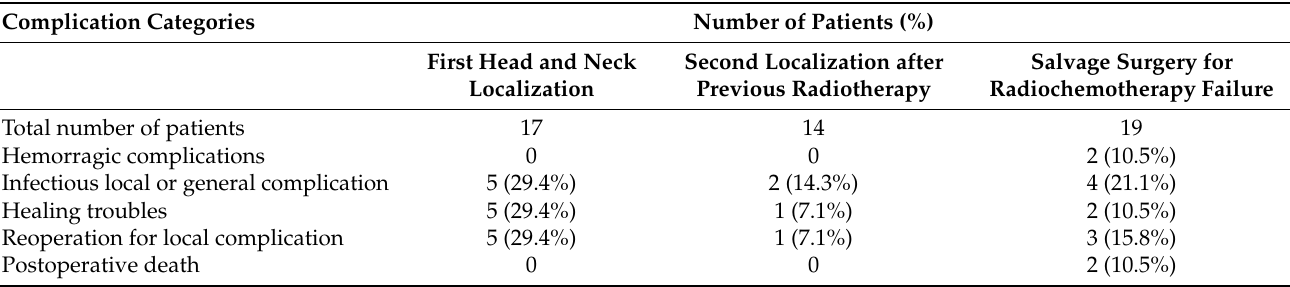
Table 3. Postoperative complication categories according to the stratification between surgery for first head and neck localization, surgery for second localization after previous radiotherapy, and salvage surgery for chemoradiotherapy failure. Complication